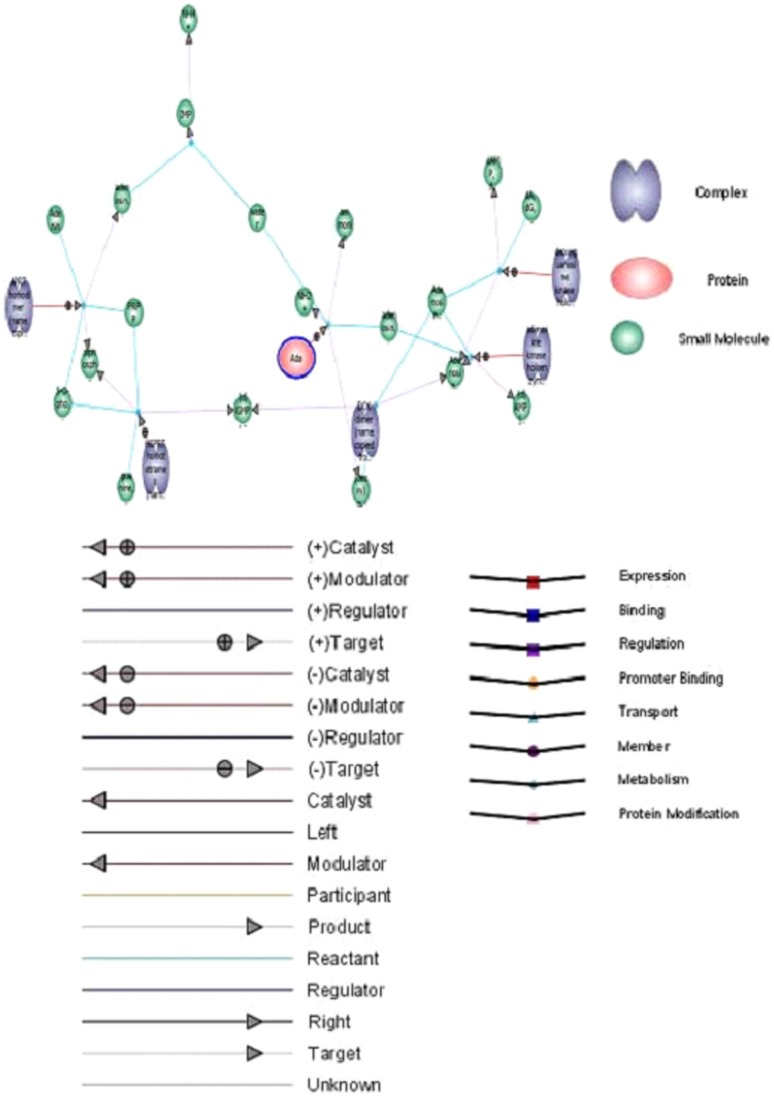
Ada network pathway obtained from network analysis of differentially expressed genes.Gene Spring software was used to construct and visualize molecular interaction networks.